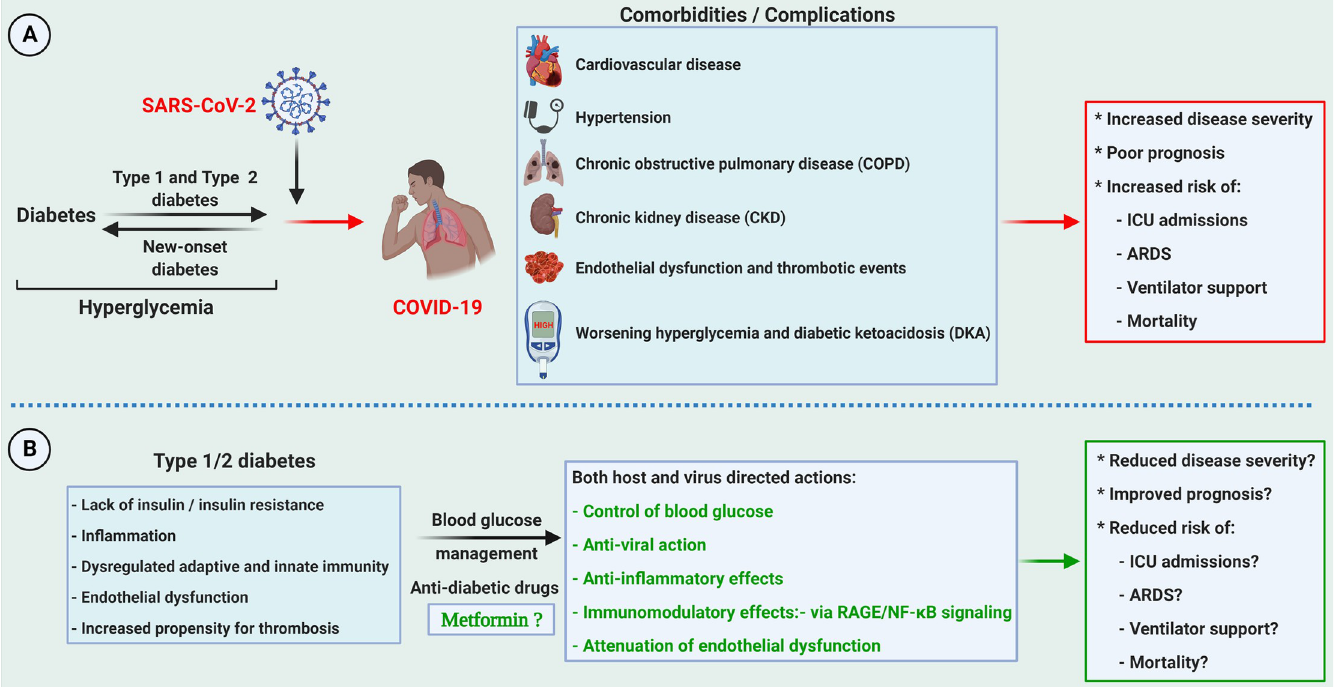
Fig 1. Bidirectional relationship of diabetes vs. COVID-19 and the potential benefits of the antidiabetic drug Metformin. (A) The relation between COVID-19 and diabetes is two sided. COVID-19 in preexisting diabetes can aggravate the disease in the presence of comorbid conditions leading to a worse prognosis. Meanwhile, new-onset diabetes, reported in patients with COVID-19 with no prior history of diabetes, could be due to adverse SARS-CoV-2 infection–mediated immune reaction and the destruction of the pancreas’ β -cells. ( B) Proper blood glucose management can mitigate the COVID-19–related complications. Metformin has multiple pleotropic actions, including immune modulation, antiviral, and anti-inflammatory effects that could mitigate disease prognosis in diabetic COVID-19 patients. Repurposing drugs through a systematic approach reduces the need for clinical testing and risk assessment and helps identify off-target effects or newly identified targets. Created with BioRender.com. ARDS, Acute Respiratory Distress Syndrome; C AU : AbbreviationlistshavebeencompiledforthoseusedthroughoutFigs 1 (cid:0) 3 : andTable 1 : Pleaseverifythatallentriesarecorrect : OVID-19, Coronavirus Disease 2019; SARS-CoV-2, Severe Acute Respiratory Syndrome Coronavirus 2.